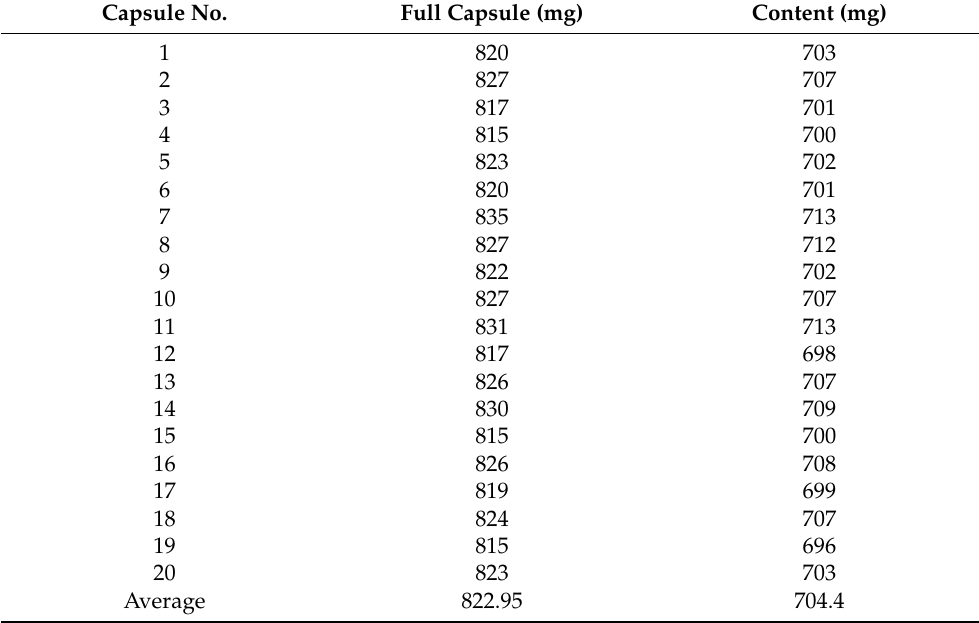
Table 3. Average mass and uniformity of mass assessment. Capsule No.